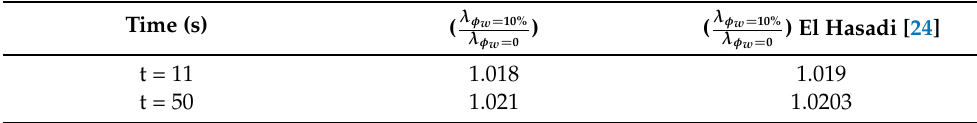
Table 3. A comparison of the current results and those of El Hasadi